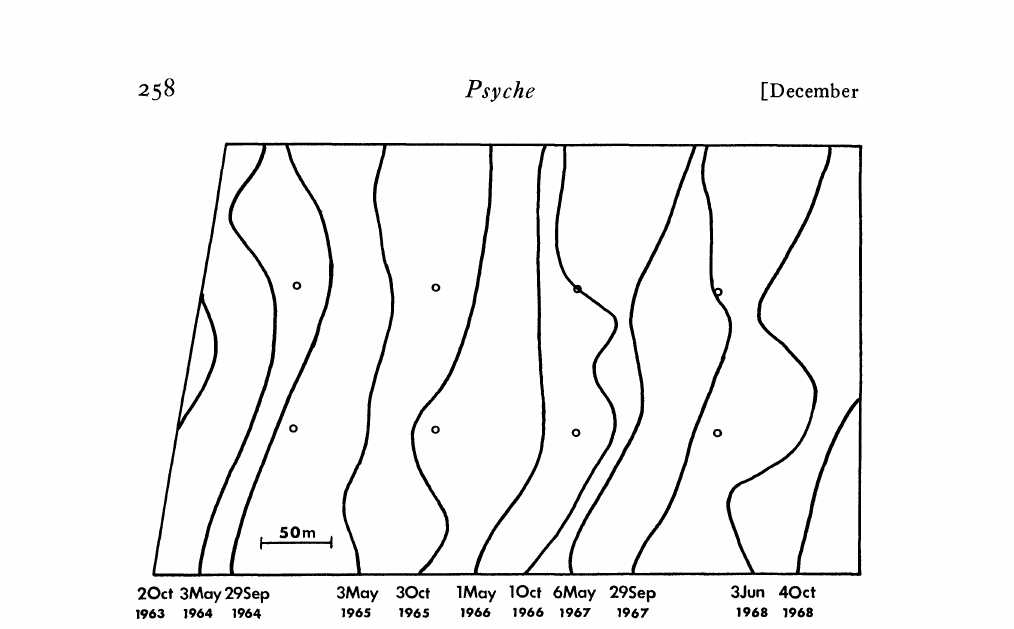
Figure 1. The forward advance of I. humilis as it displaces P. cali- fornicus in an old field from October 1963 to October 1968. Reference markers are located at intervals of 100 meters